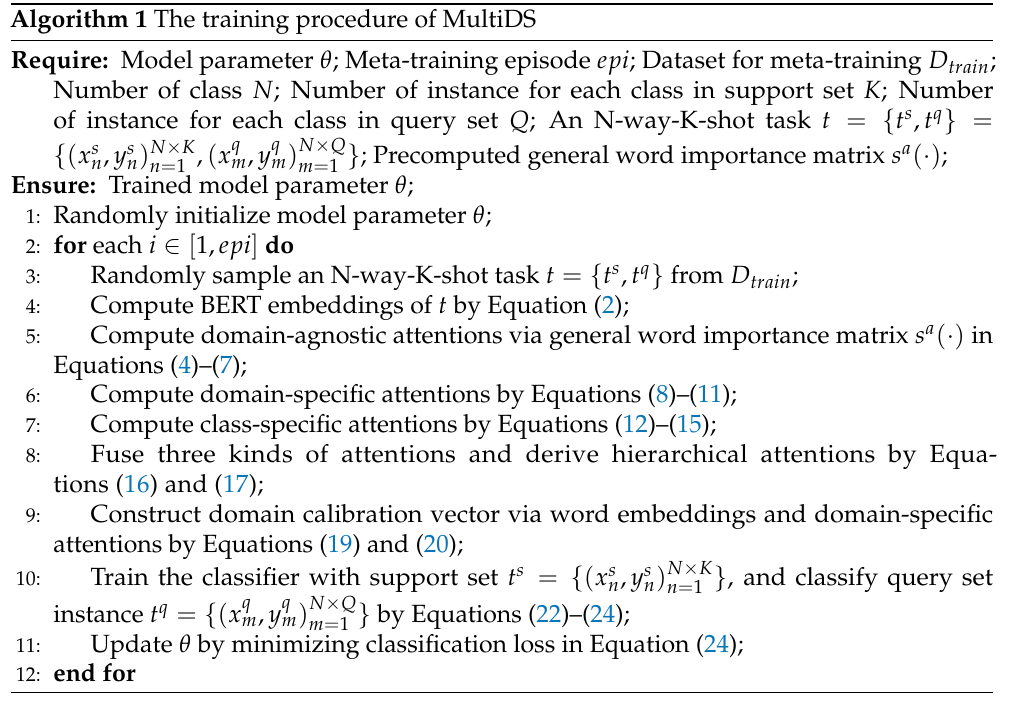
Algorithm 1 The training procedure of